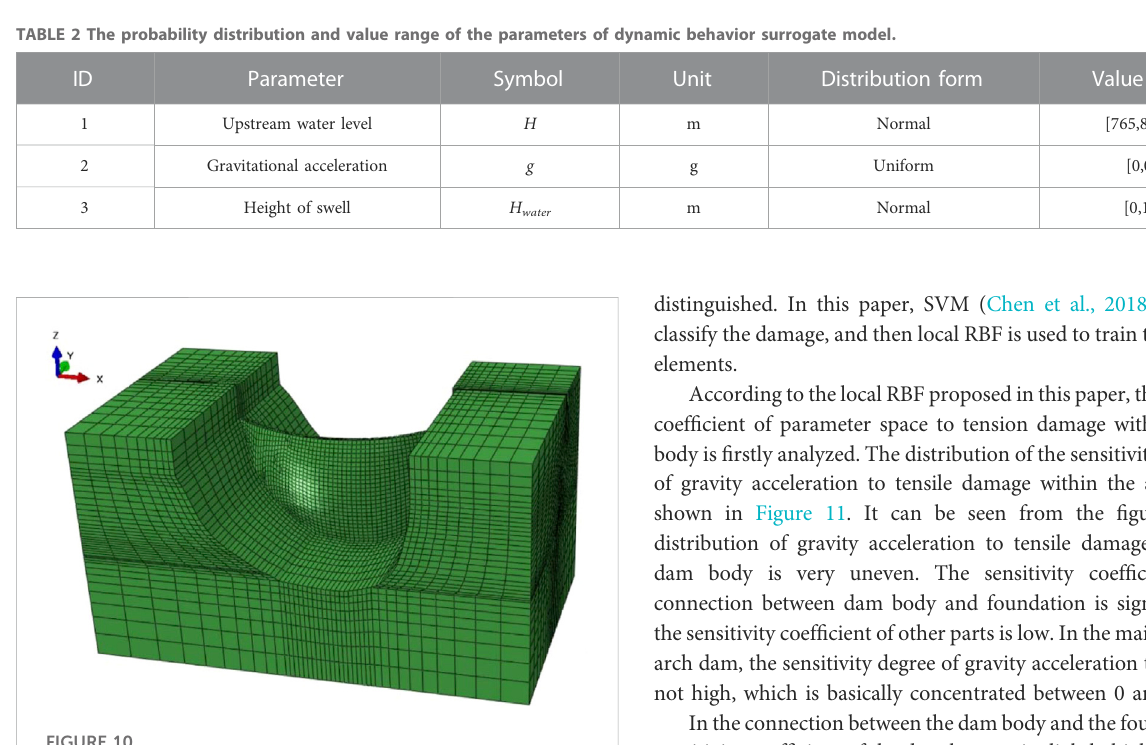
FIGURE 10 A dam numerical model for establishing dynamic behavior surrogate